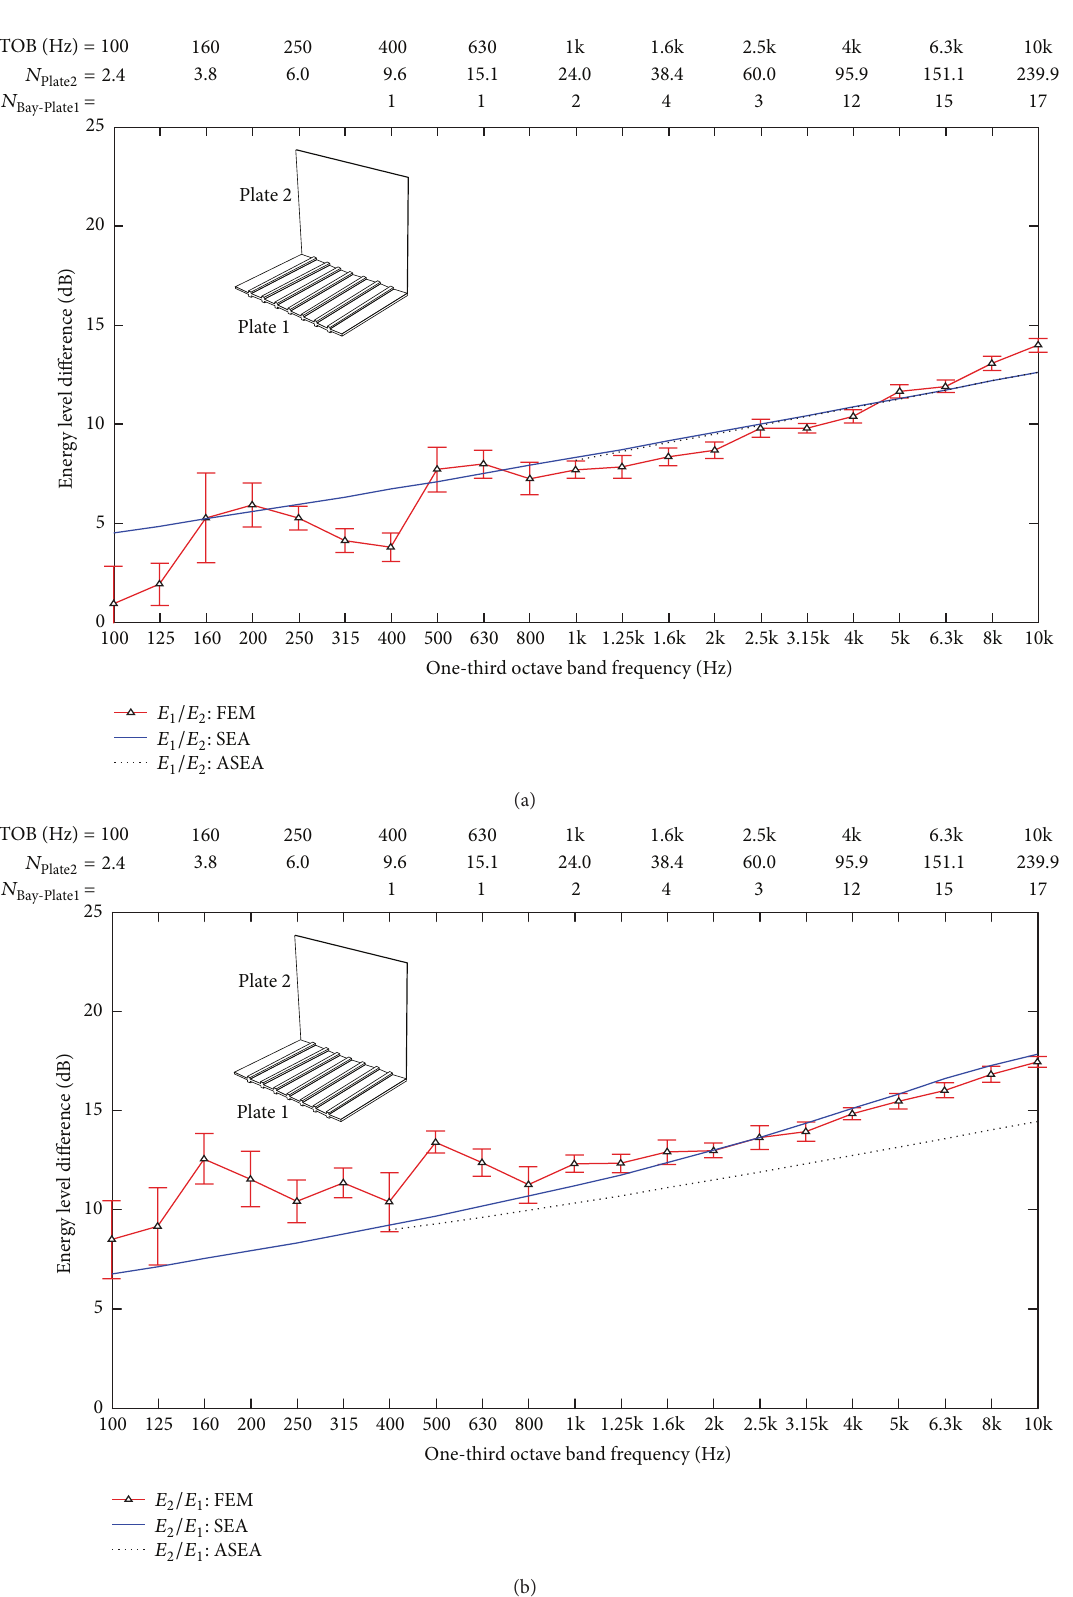
Figure 12: L-junction C. Energy level differences between the isotropic, homogeneous plate (Plate 1) and the periodic ribbed plate (Plate 2) with excitation of (a) Plate 1 and (b) Plate